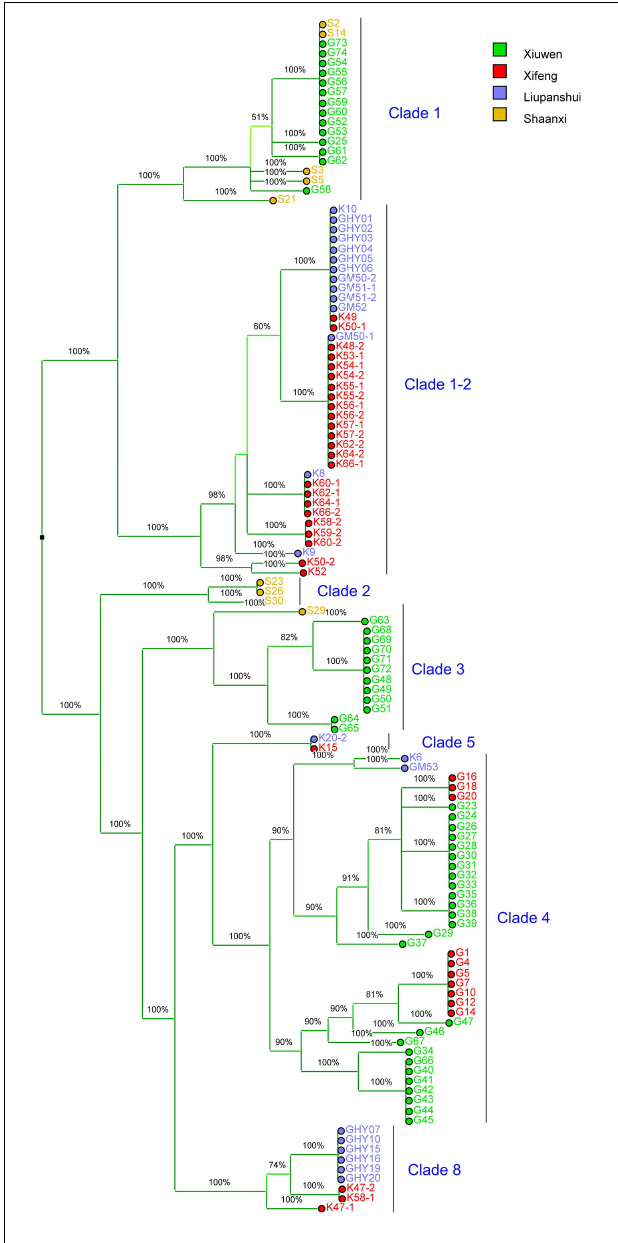
FIGURE 1 | Majority UPGMA dendrogram constructed using Bionumerics 8.0 software based on MLVA data for 117 Pseudomonas syringae pv. actinidiae biovar 3 isolates from Guizhou and Shaanxi Province, China. The MLVA clustering method is as per Zhao et al. (2019b). The colored squares indicate the geographical source of the isolates. Xiuwen, Xifeng and Liupanshui are three main kiwifruit cultivating areas in Guizhou Province. The clade-populations are designated based on both MLVA typing results and whole-genome